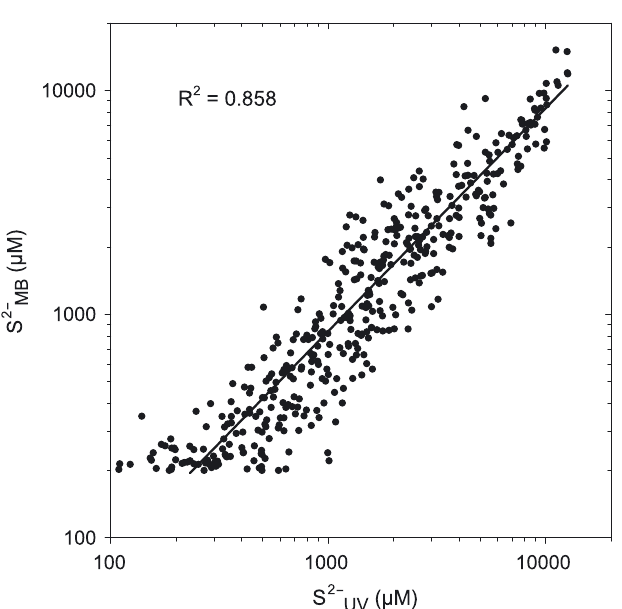
Fig. 7. Relationship between sediment total free sulfide con- centrations analysed by UV spectrophotometry (S 2− UV ) and methylene blue (S 2− MB ) methods from all aquaculture sites and sampling depths included in this study (Tables 1 & 2, n = 927). The regression line and correlation coefficient are shown. S 2− MB data below the 200 μM limit of detection are